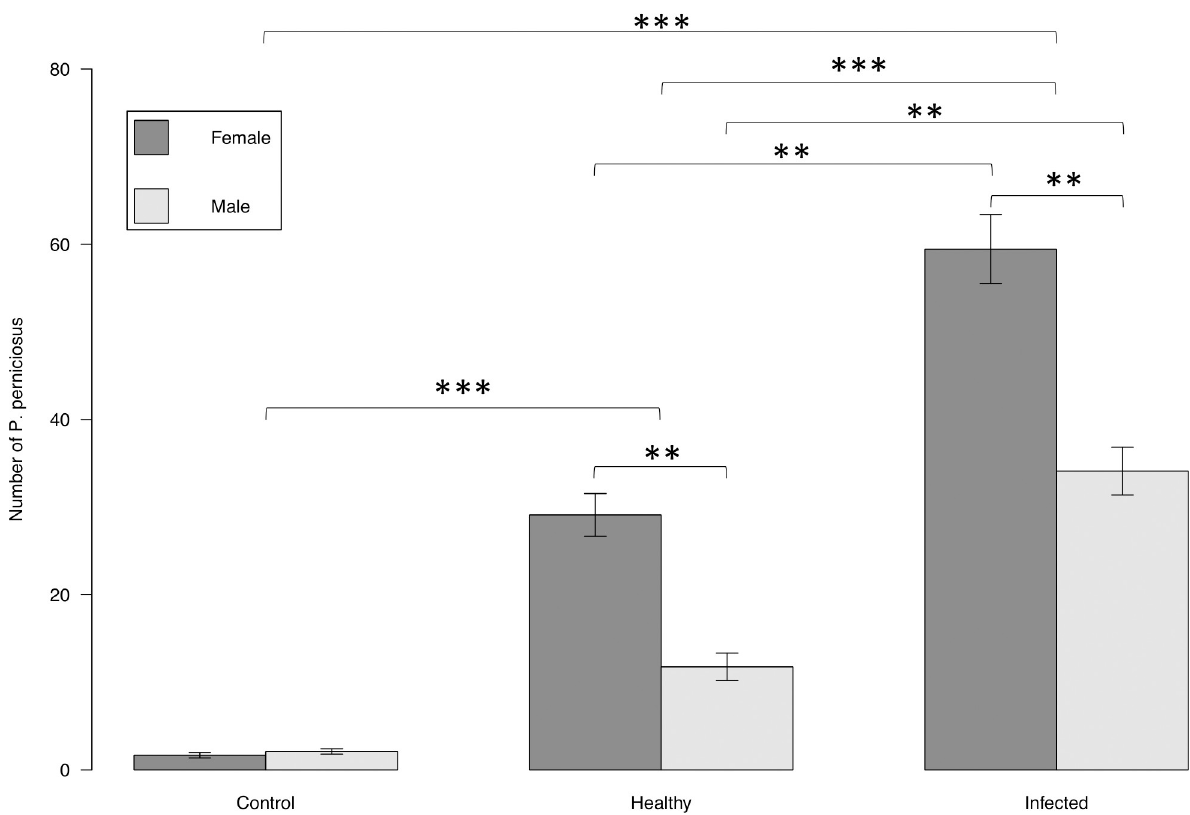
Fig 8. Mean number of males and females P . perniciosus attracted toward uninfected vs. infected dogs under field conditions. Y axis represents the number of sand flies collected from the cage baited with infected dog, from the cage with uninfected dog, and from the un-baited cage. X axis represents the infection status of the dogs. Boxes are limited by the minimal and maximal value. Error bars correspond to the standard error. Significance code: p � 0.01 �� ; p � 0.001 ��� .